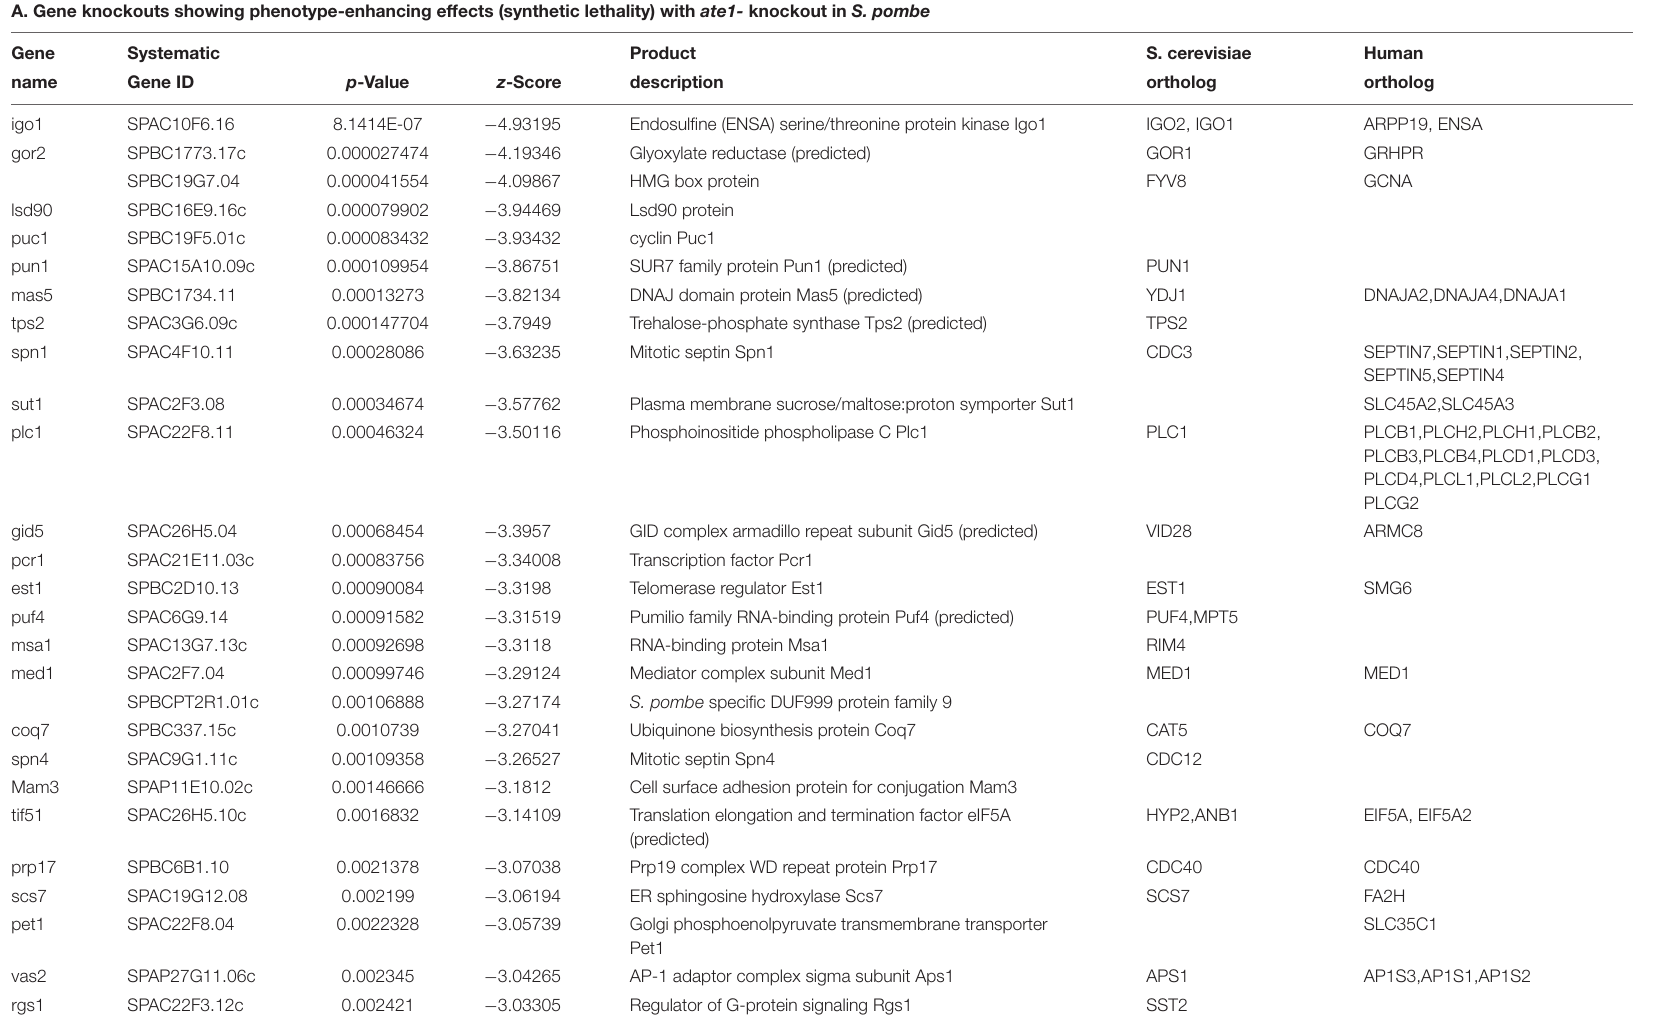
TABLE 1 | Genes whose knockout showing genetic interaction, either phenotype enhancement (1A) or suppression (1B) with ate1 in S. Pombe. A. Gene knockouts showing phenotype-enhancing effects (synthetic lethality) with ate1- knockout in S.